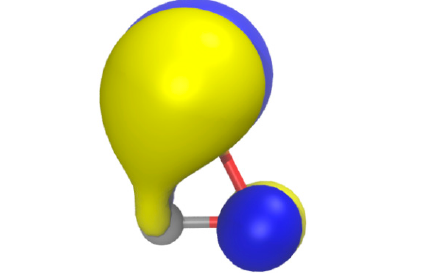
Figure 7. Computed (B3LYP/def2-TZVPP) Kohn-Sham isosurface (0.06 au) for the HOMO of 14 .